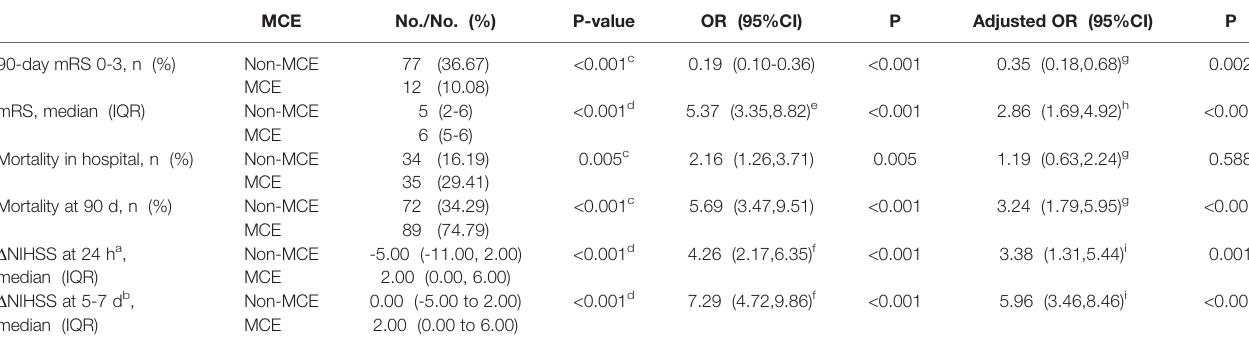
TABLE 2 | The impacts of MCE on clinical